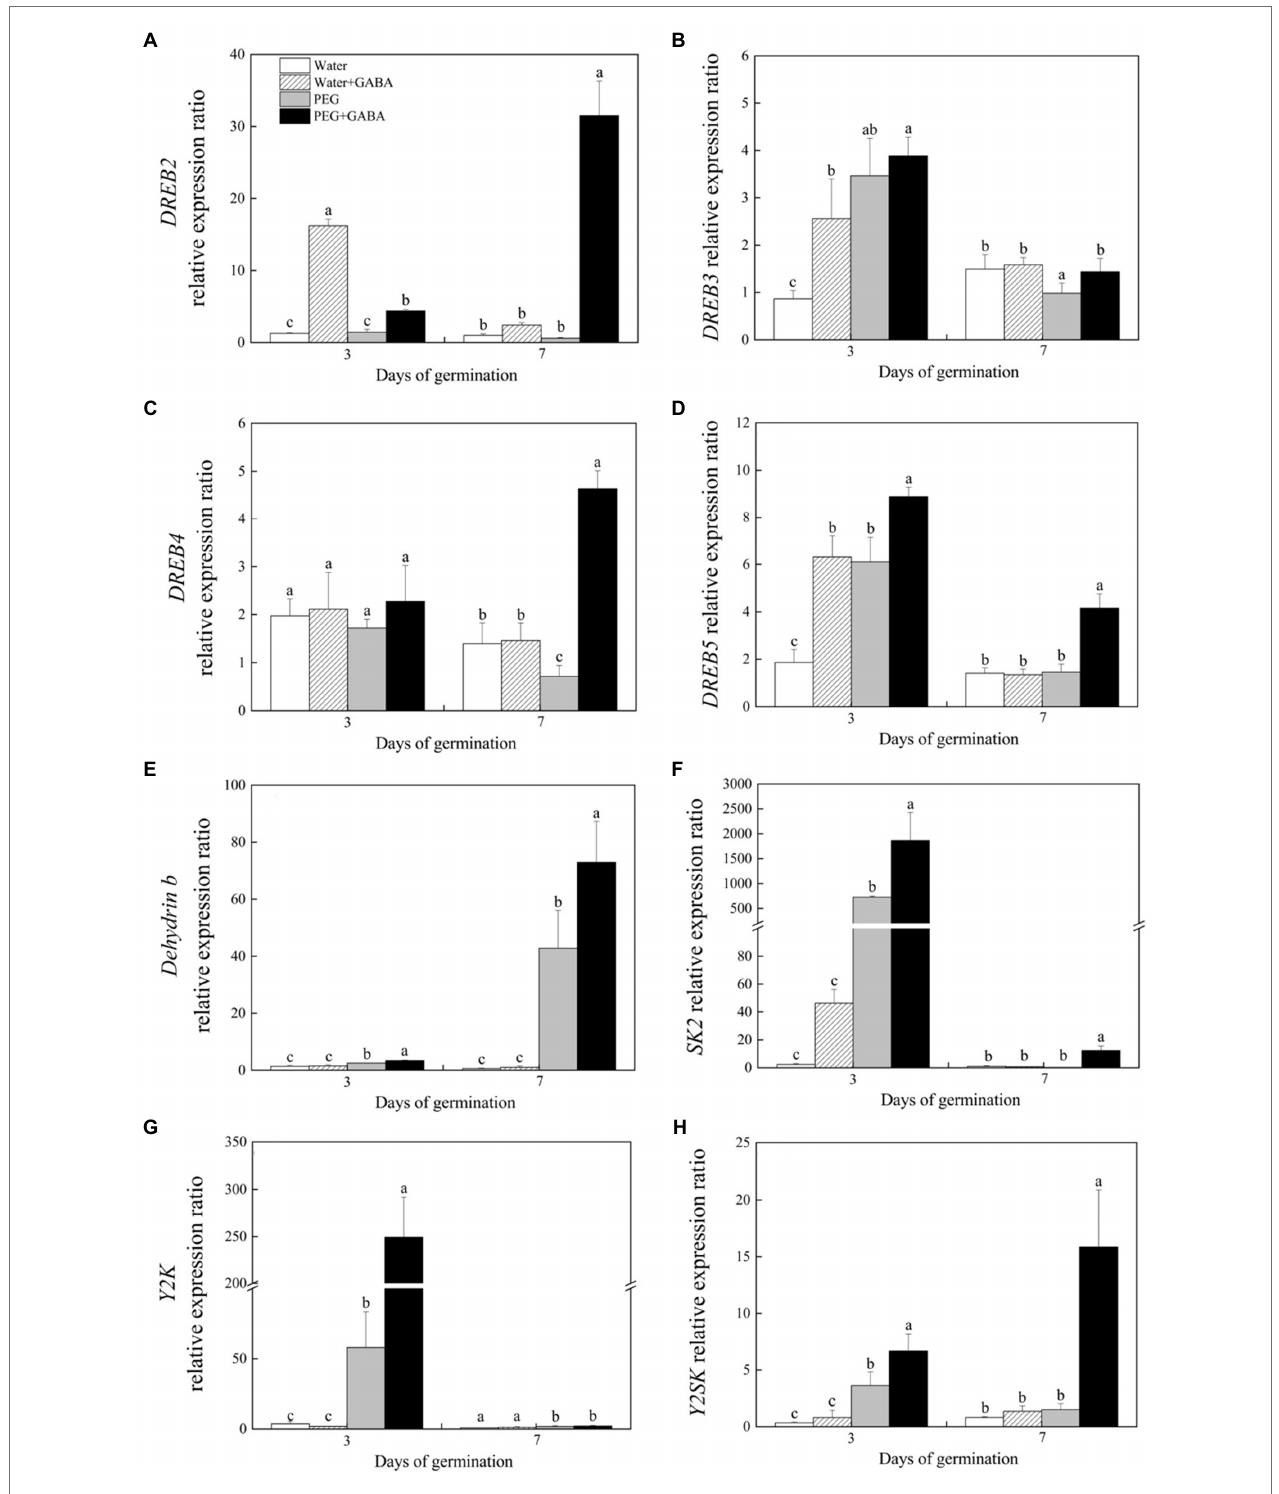
FIGURE 7 | Effects of seed priming with deionized water or γ -aminobutyric acid (GABA) on the relative expression levels of DREB2 (A) , DREB3 (B) , DREB4 (C) , and DREB5 (D) transcription factors and the relative expression levels of Dehydrin b (E) , SK2 (F) , Y2K (G) , and Y2SK (H) during the germination of white clover seeds under water